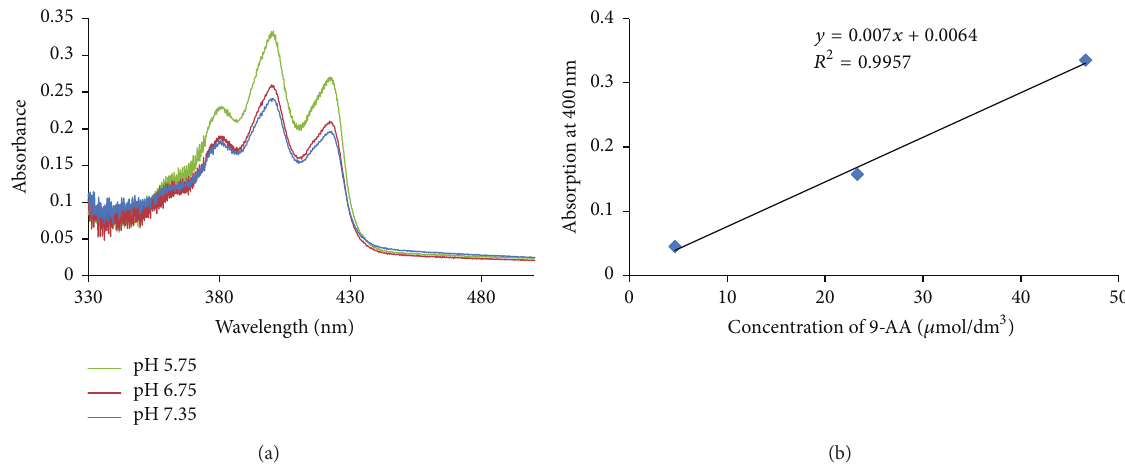
Figure 4: (a) UV/VIS absorbance spectra of 9-AA released from FNP/9-AA@PSN at pH values 7.35, 6.75, and 5.75. (b) Calibration curve for determination of 9-AA